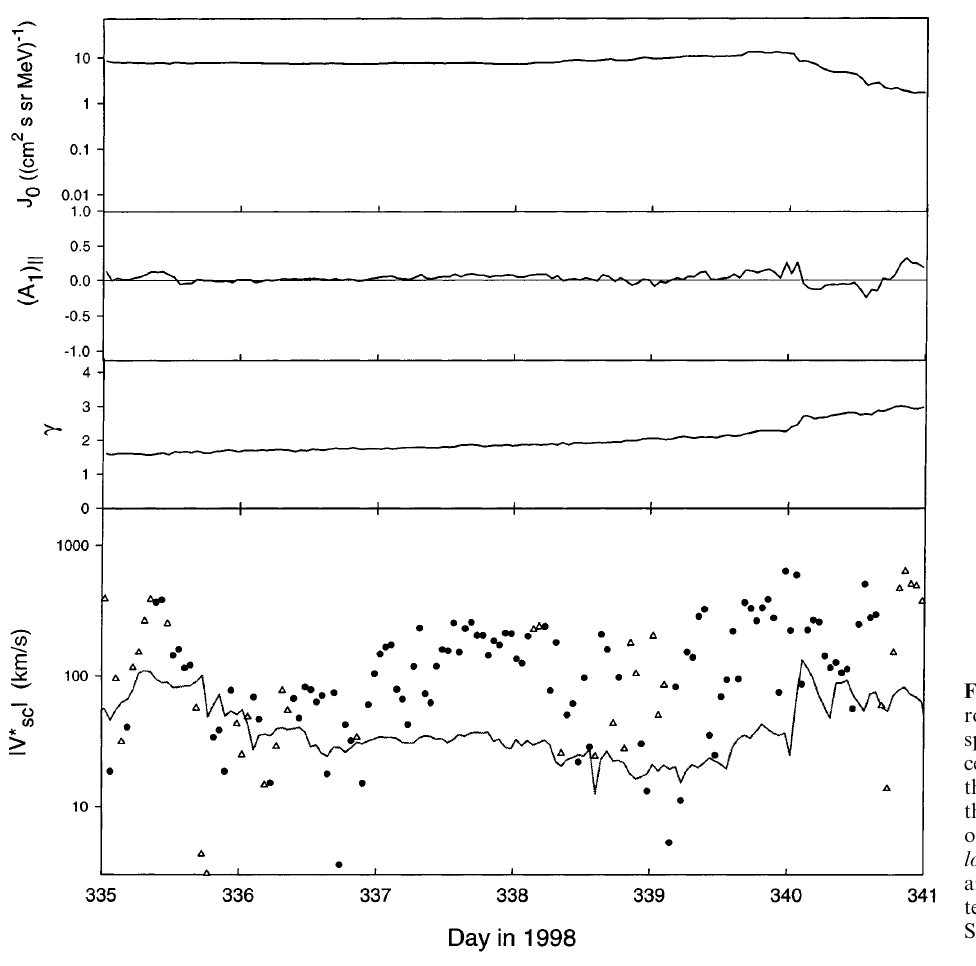
, (cid:133) A 1 (cid:134) , 0 k j . In the sc